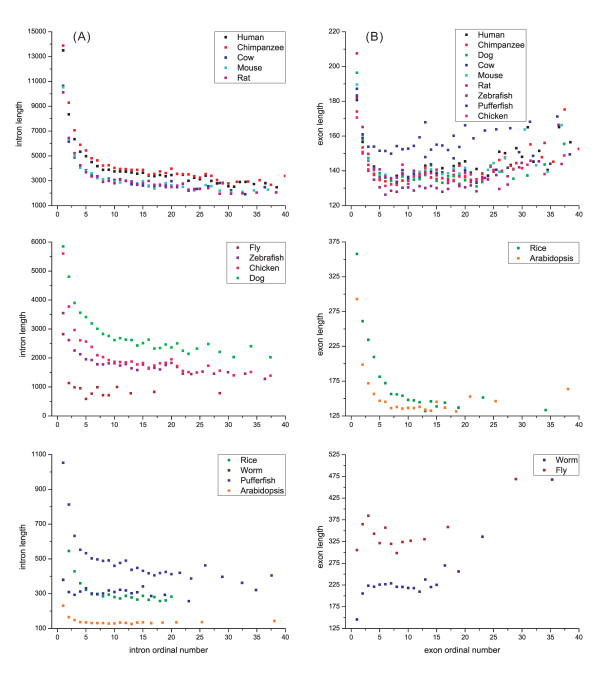
Variation patterns of intron (A) or exon length (B), as a function of its ordinal number. Only introns or exons with ordinal numbers ≤ 40 were shown in the figures; each dot contains > 1000 samples.